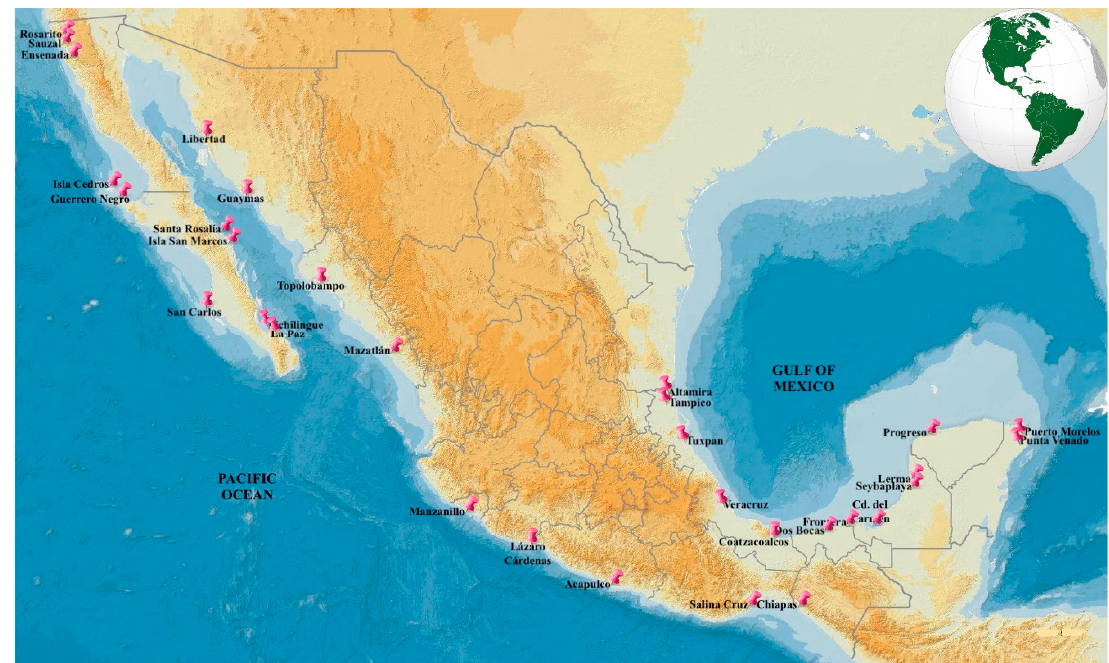
Figure 1. Location of the Mexican ports. Own elaboration considering to data available from [9].